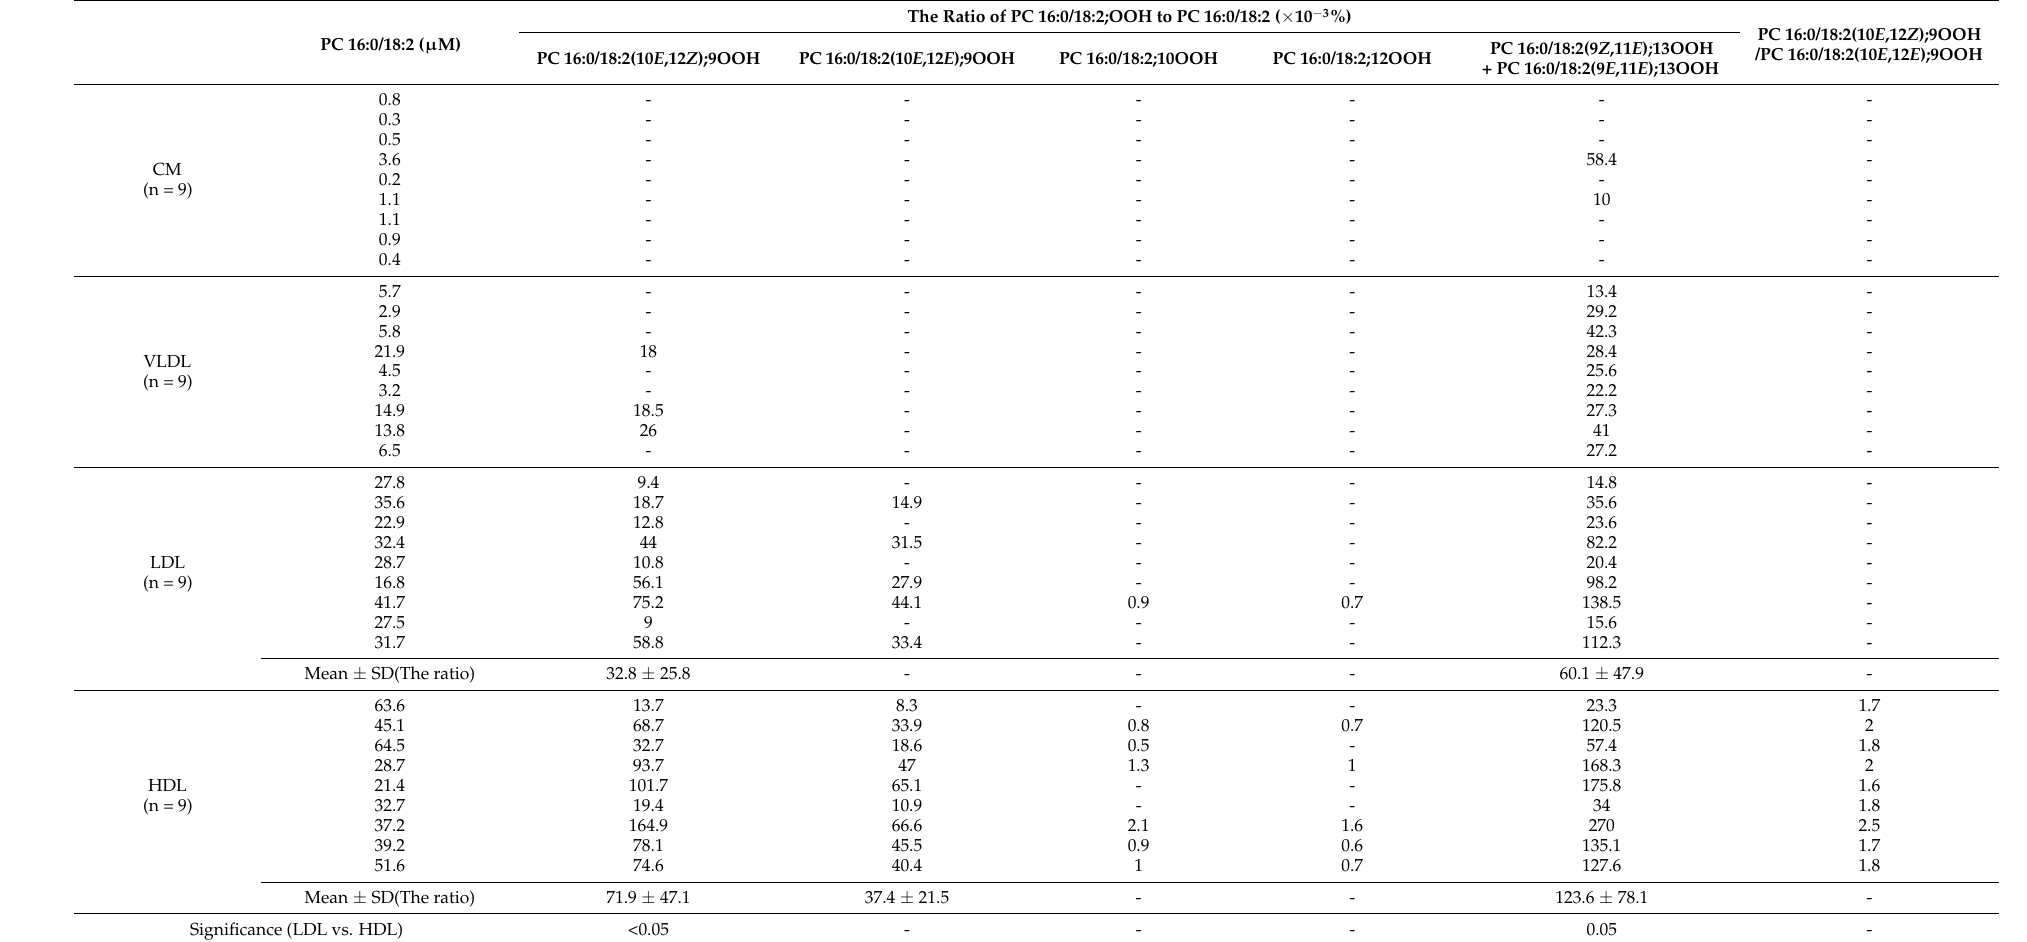
Table 1. The ratio of PC 16:0/18:2;OOH to PC 16:0/18:2 and CE 18:2;OOH to CE